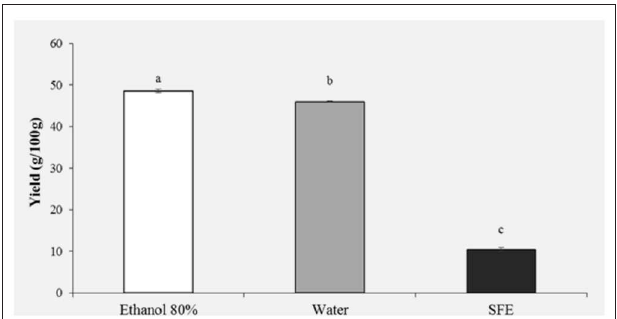
FIGURE 2 | Total phenolic content (mg GAE/g extract) of honey bee pollen (HBP) extracts obtained with different solvents. Lowercase letters indicate significant differences between different solvents (a, b, c: P <